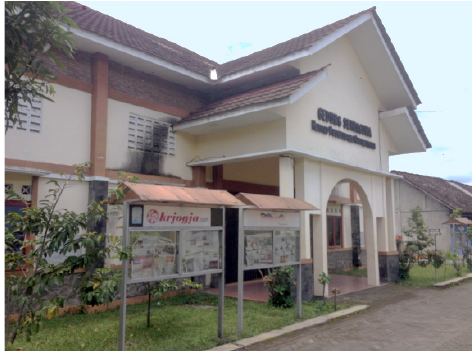
Figure 3. Multipurpose building